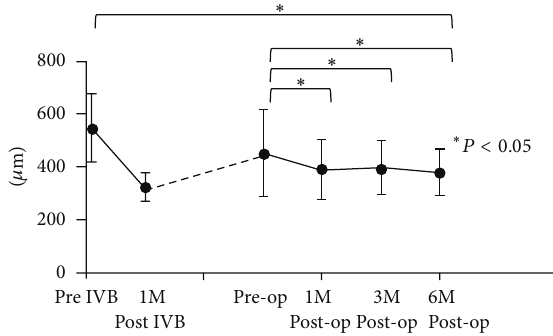
Figure 3: Changes in average mean retinal thickness. Mean MRT was significantly improved after 1 month of IVB compared to the baseline. Mean MRT was significantly improved at 1 month after vitrectomy, compared to the pre-op MRT ( ∗ 𝑃 < 0.05 ). MRT: mean retinal thickness; post IVB: 1 month from